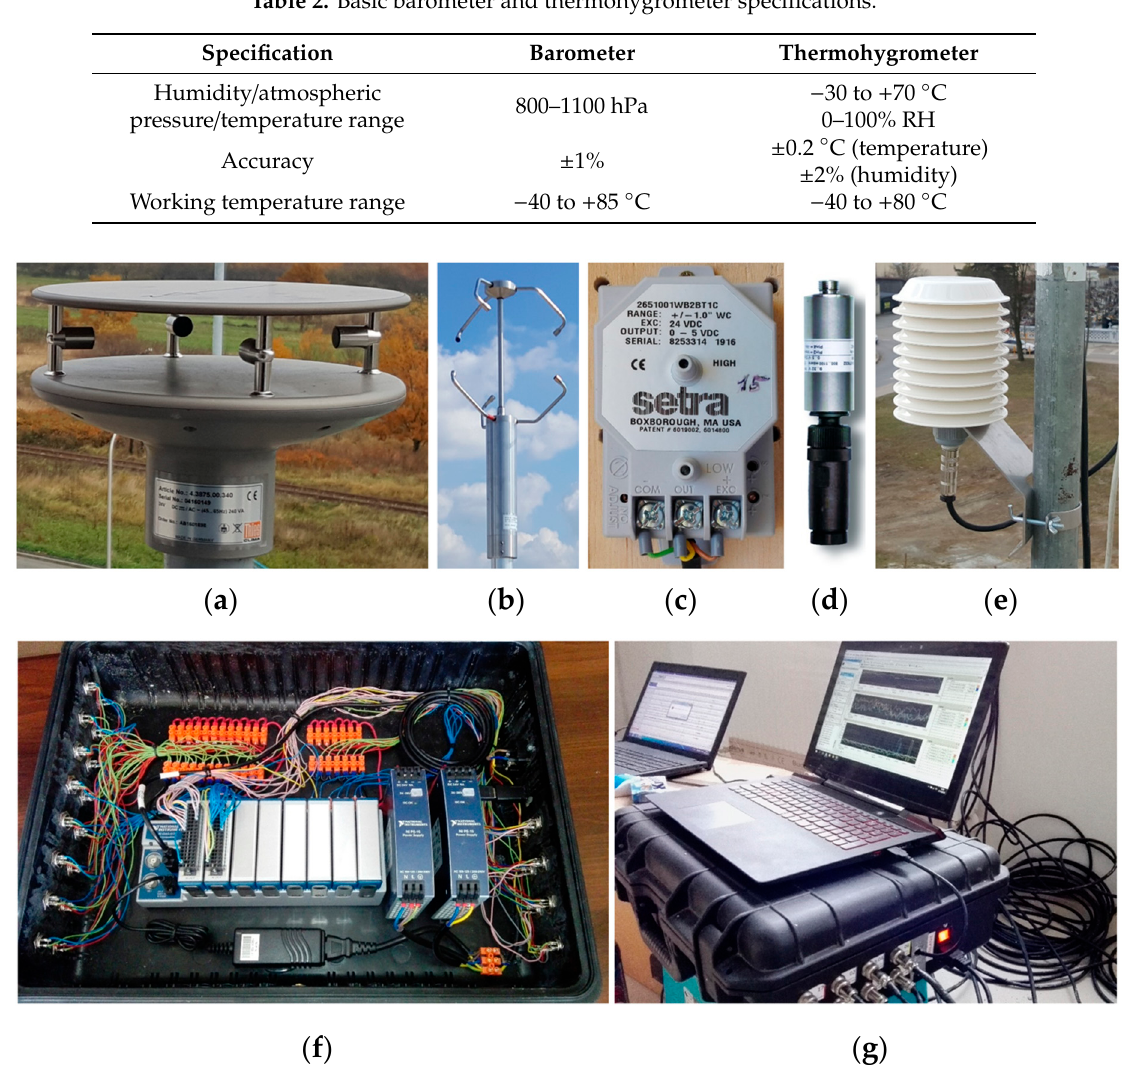
Table 1. Basic anemometer specifications. 2D, two-dimensional; 3D, three-dimensional.